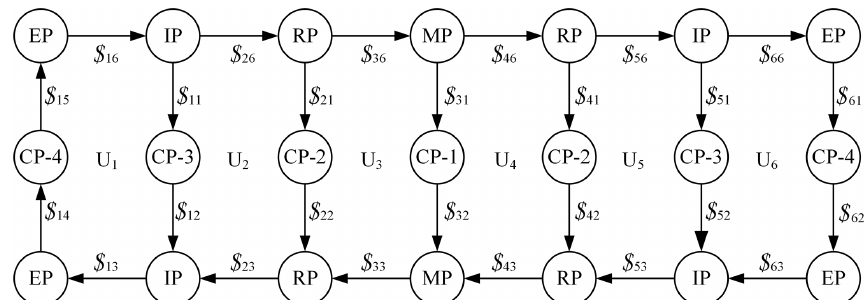
Figure A2. Topological constraint graph of the deployable string.